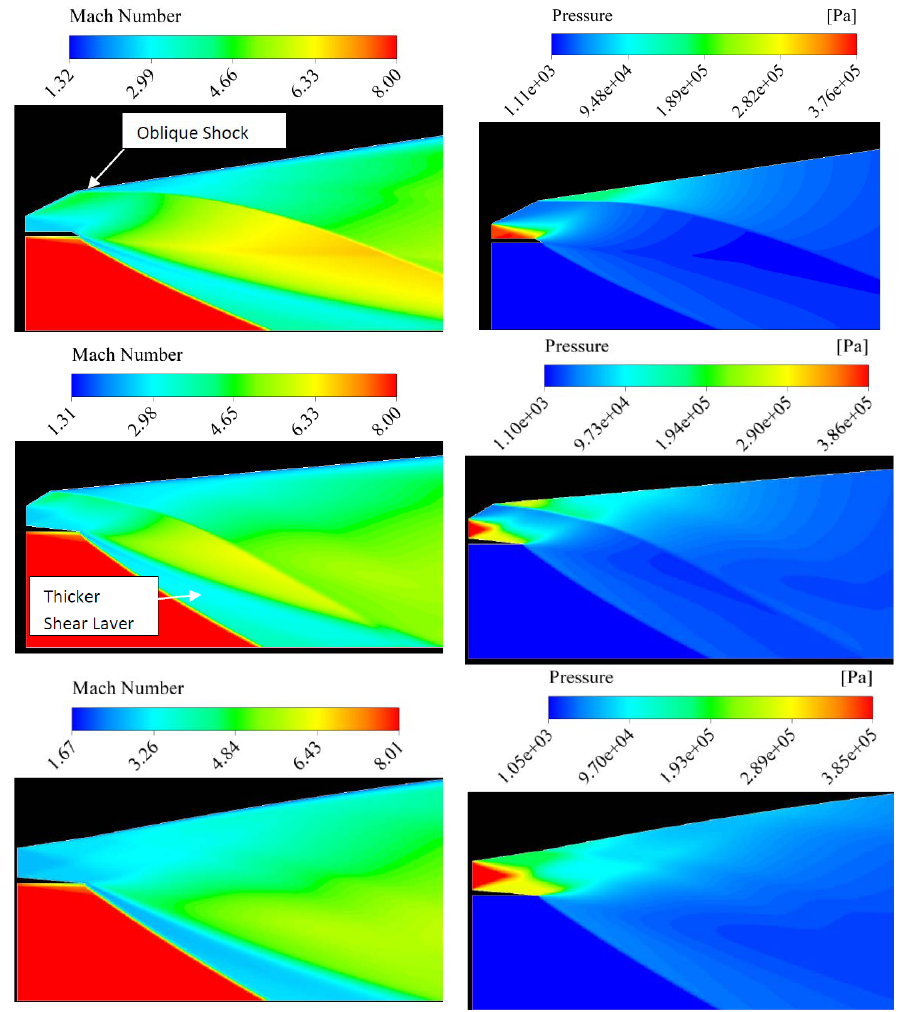
Figure 12. Mach number ( left ) and pressure contours ( right ) for DP279 ( top ), DP690 ( middle ), and DP487 ( bottom ).